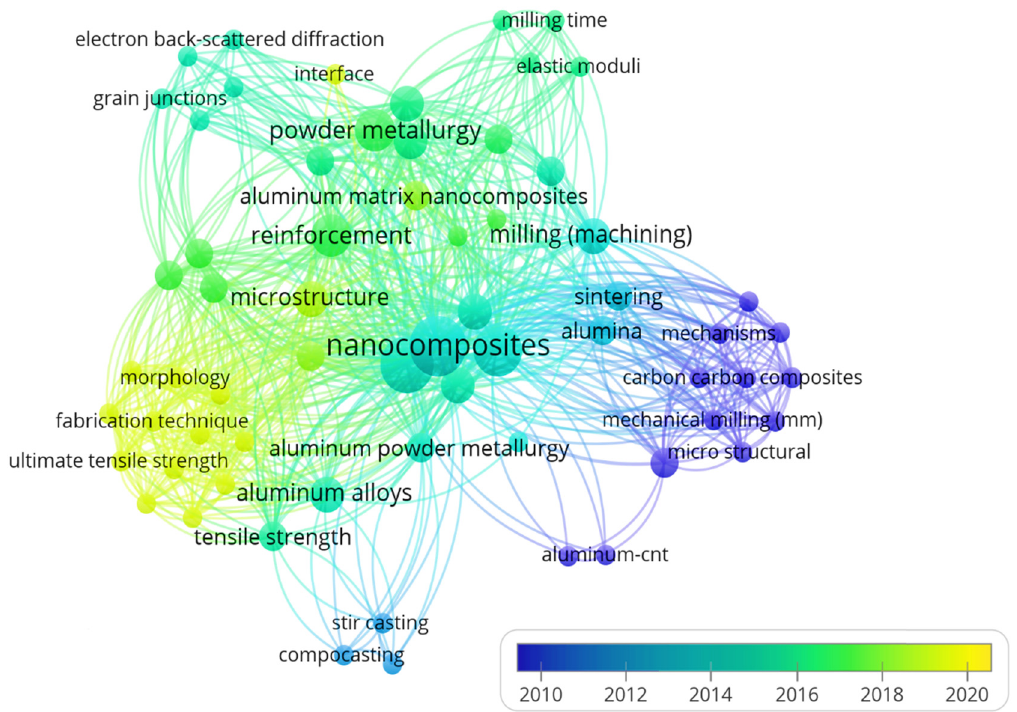
Figure 2: Systematic mapping summary of scienti fi c advancements regarding an implication of MWCNTs on a physicomechanical, interface adhesion strength, and morphological characteristics of MWCNTs/Al – Cu – Mg – T351 alloy cast nanocomposites.